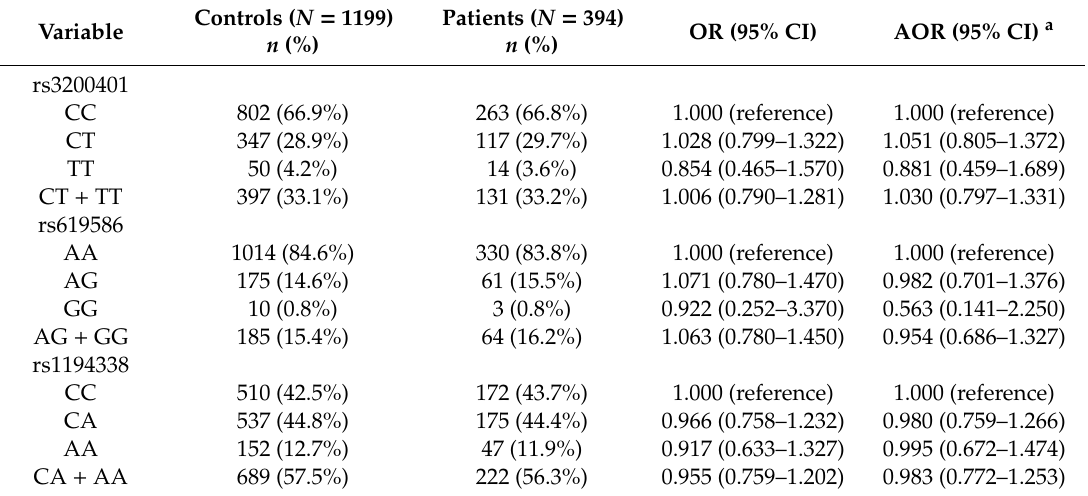
Table 2. Genotyping and allele frequency of MALAT1 single nucleotide polymorphisms (SNPs) in hepatocellular carcinoma and normal